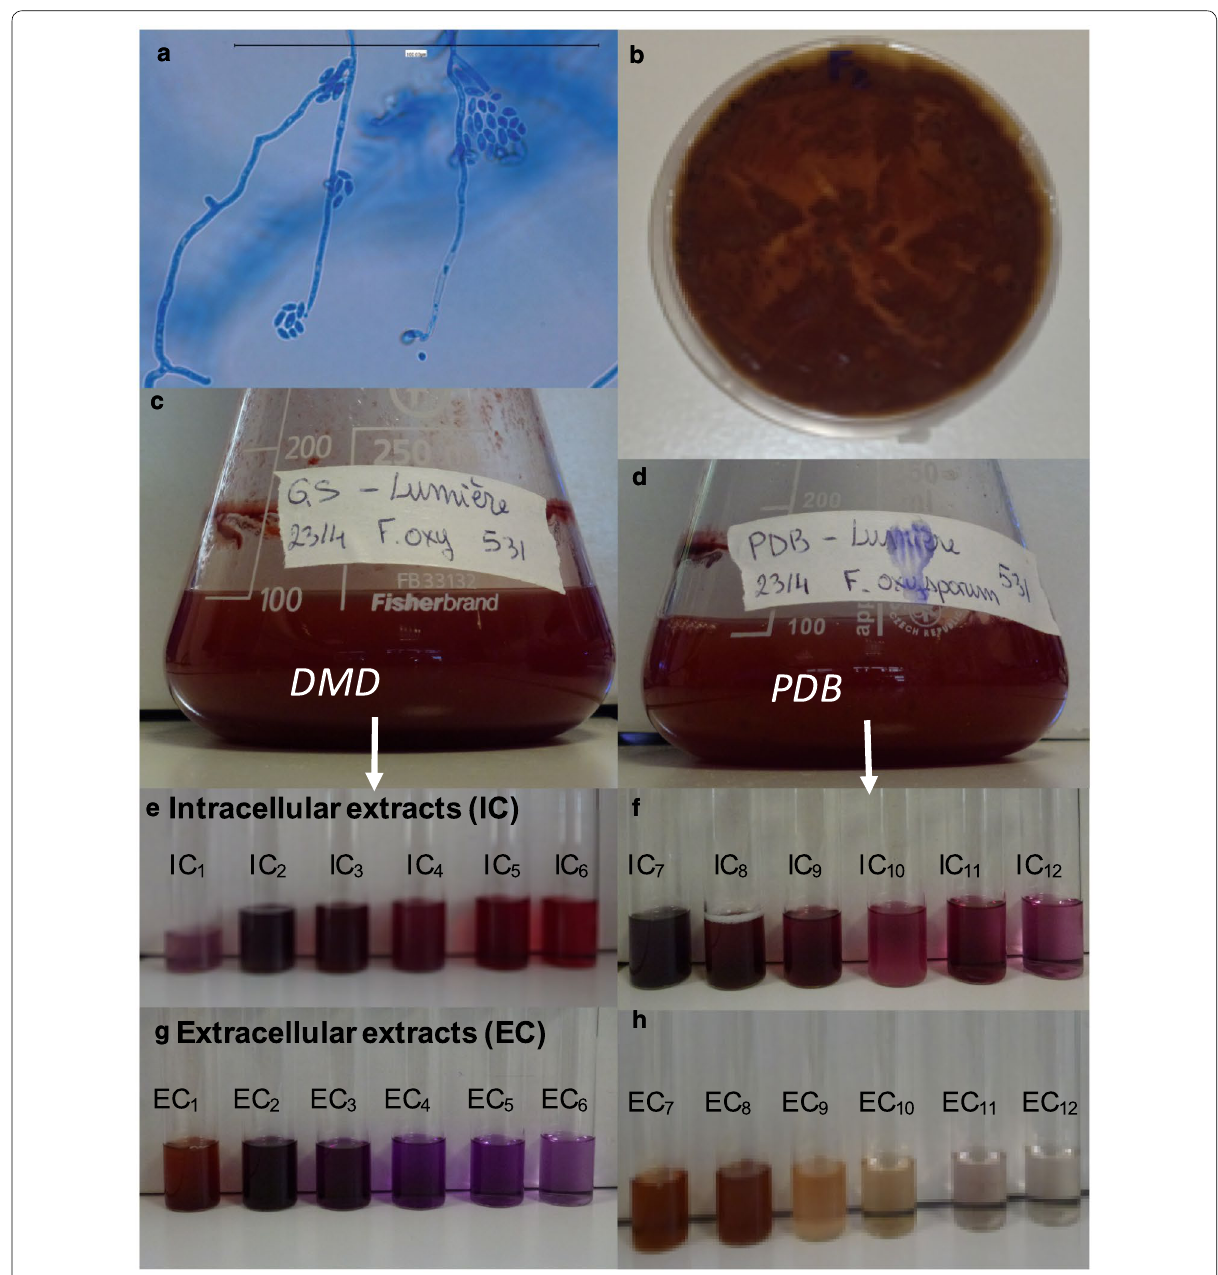
Fig. 1 a Morphology of the filamentous fungus Fusarium oxysporum , b grown on potato-dextrose-agar (PDA) plate, c in submerged culture of defined minimal dextrose broth (DMD), and d in potato-dextrose broth (PDB). Intracellular (IC) and extracellular (EC) liquid extracts obtained using